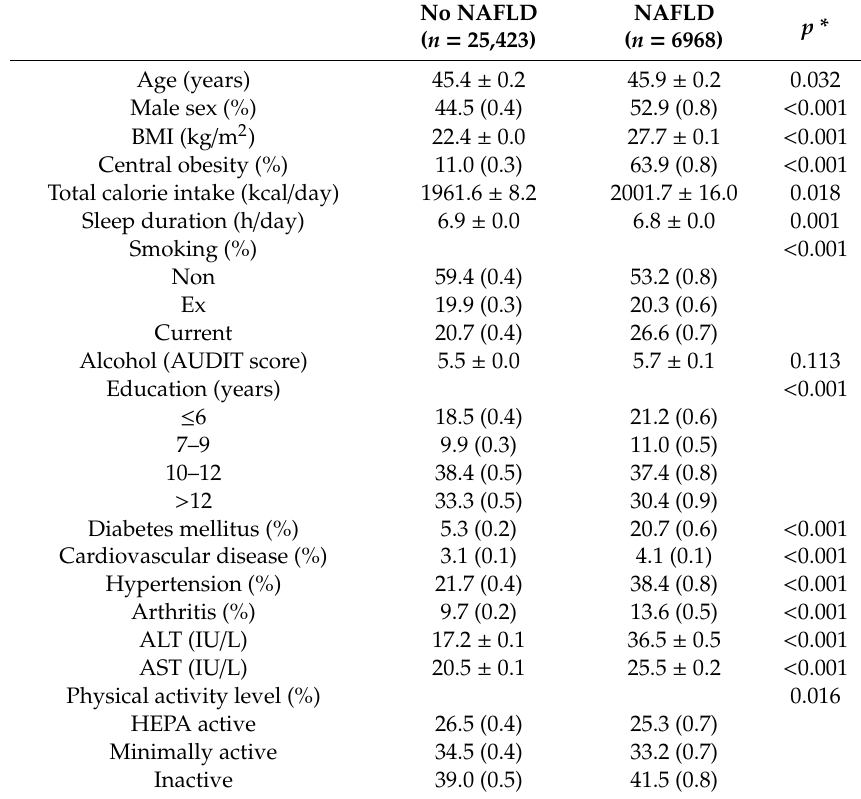
Table 2. Characteristics of participants by the presence of NAFLD ( n =